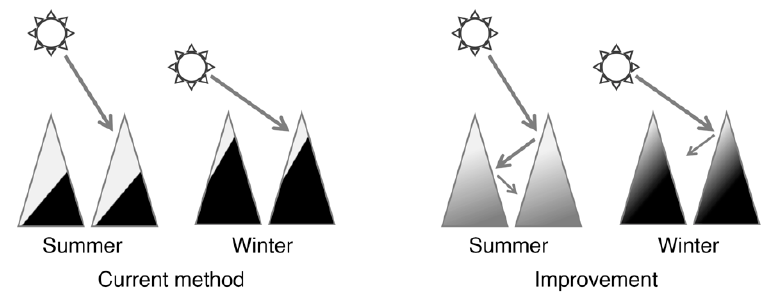
Figure 18. Reflection of light by an illuminated canopy and the brightness of the lower canopy.